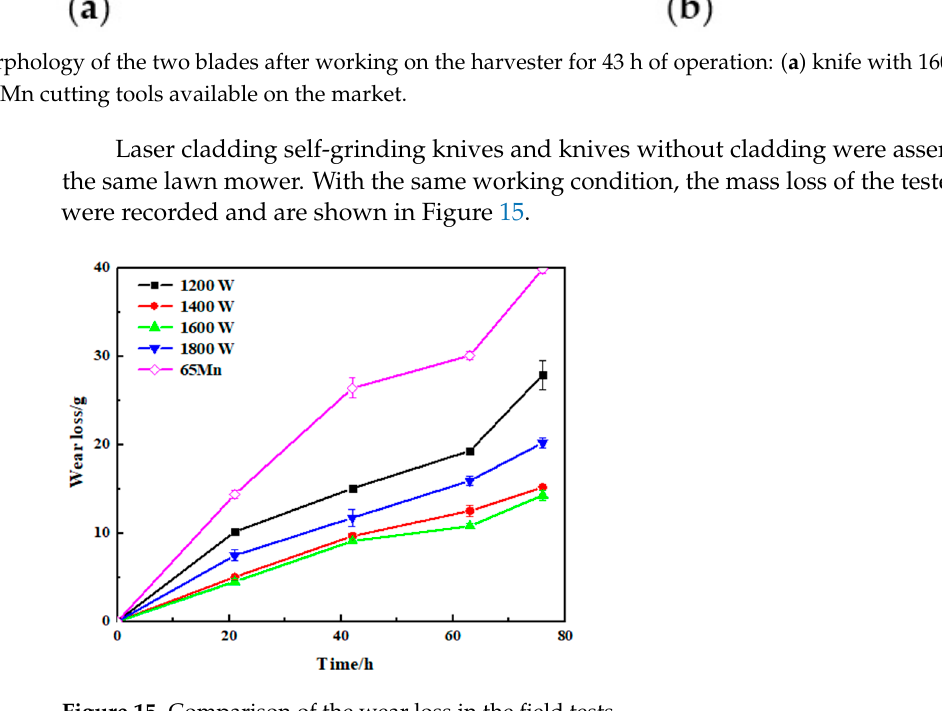
Figure 14. Macro-morphology of the two blades after working on the harvester for 43 h of operation: ( a ) knife with 1600 W laser cladding; ( b ) 65 Mn cutting tools available on the market.